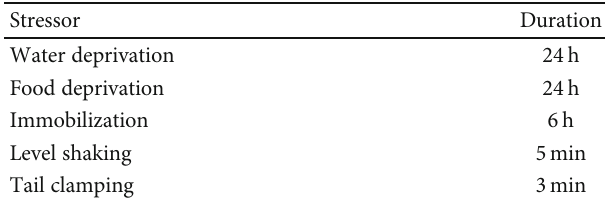
Table 1: The stressors of the 21-day CUMS